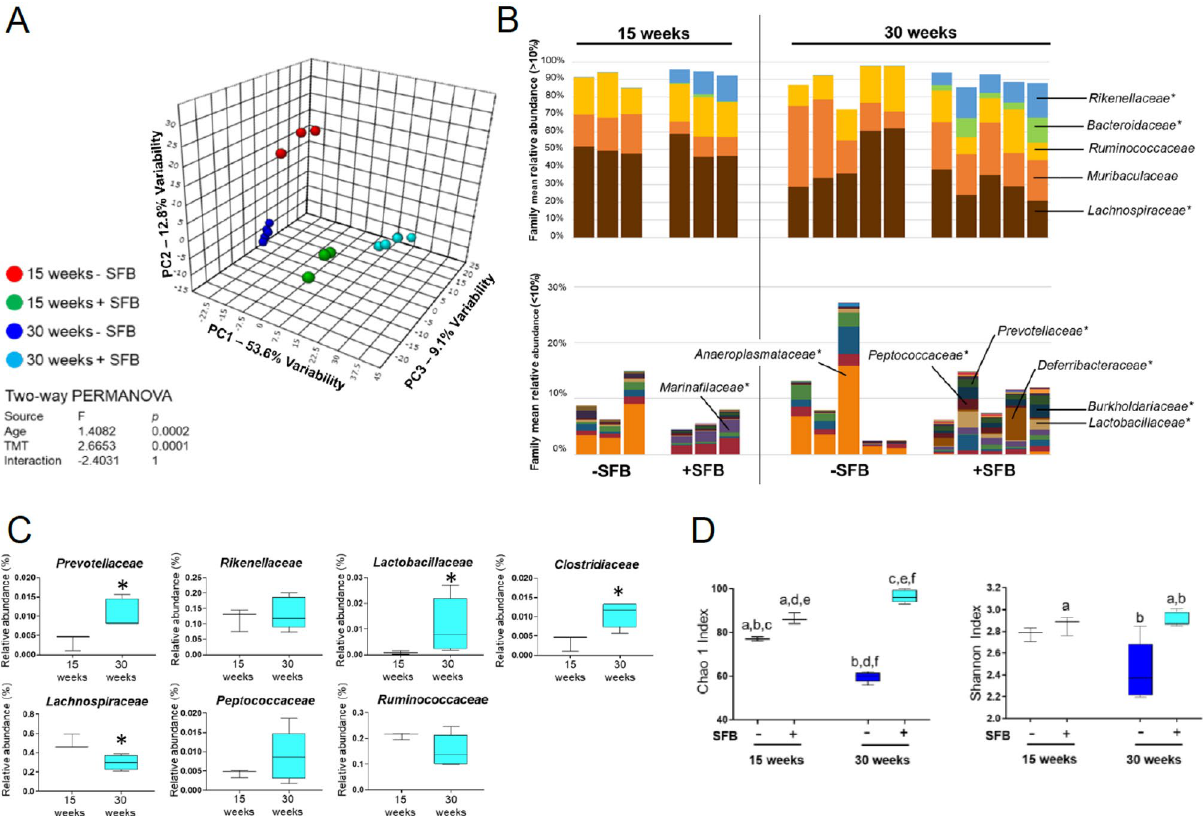
Figure 6. Gut bacterial microbiome changes between +/−SFB NZM2410 mice at 15 or 30 weeks of age. ( A ) Principal coordinate analysis (PCoA) of representative fecal samples from SFB negative or SFB positive colonized mice at 15 and 30 weeks of age. Figure legend of groups located at right of PCoA. Statistical significance determined using two-way PERMANOVA ( p ≤ 0.05 statistically significant). ( B ) Bar charts of relative abundance of taxa at family level from SFB negative or SFB positive colonized mice at 15 and 30 weeks of age. Statistical significance determined using two-way ANOVA or Kruskal–Wallis, depending on normality of data as determined by Shapiro–Wilk normality testing and Benjamini–Hochberg correction for multiple testing ( p ≤ 0.05 statistically significant). Statistically significant families indicated by asterisk. ( C ) Percent relative abundance of significant taxa at the family level from representative fecal samples of SFB positive mice at 15 and 30 weeks of age. Statistical significance determined using the Mann Whitney test ( p ≤ 0.05 statistically significant). Asterisks denote statistical significance between groups. ( D ) Chao1 and Shannon estimate of microbial richness and diversity plotted by Tukey box and whisker graph (n = 3–5 per group).